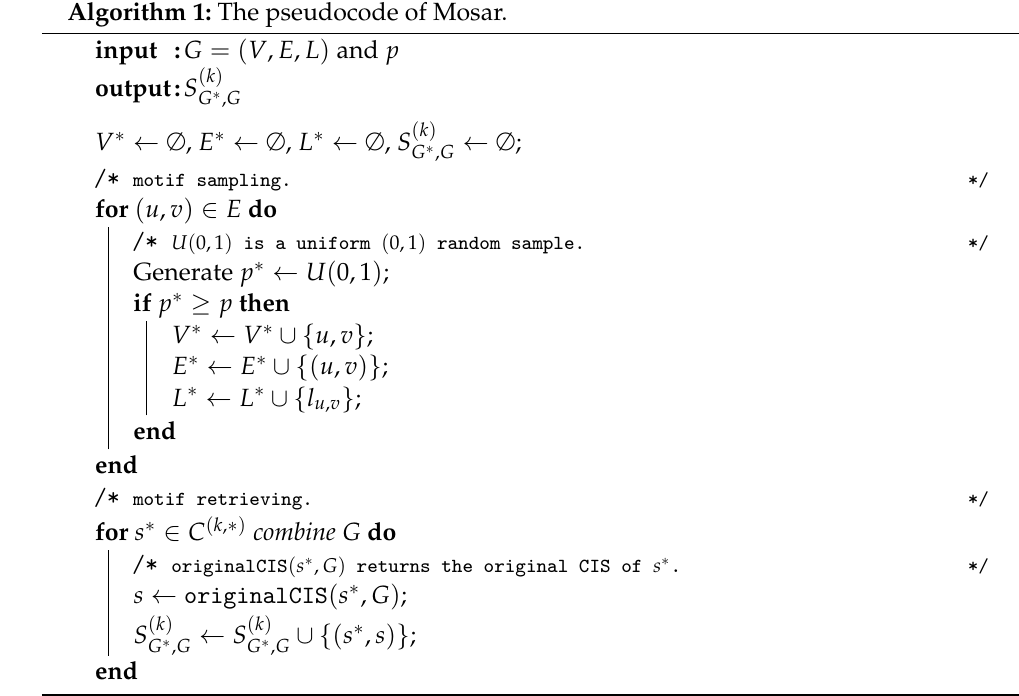
Algorithm 1: The pseudocode of